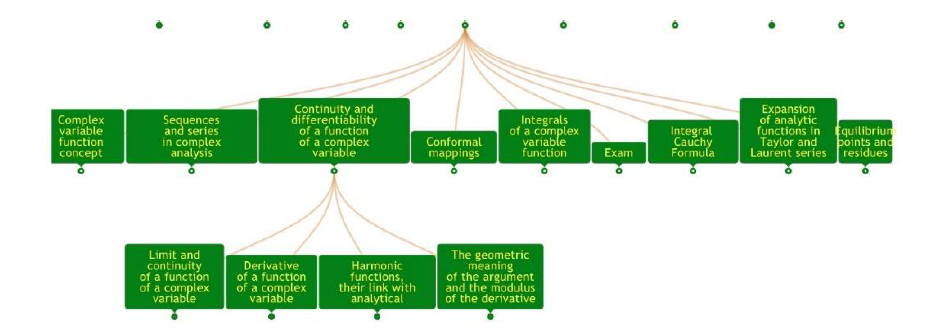
Fig. 1. The Chapters and paragraphs e-learning «Complex analysis» DLS NOMOTEX .